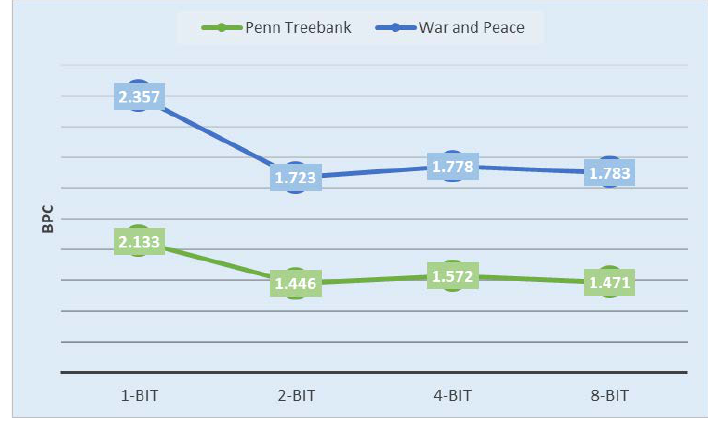
Figure 7. The BPC of our quantization method on different datasets across all varying bits.